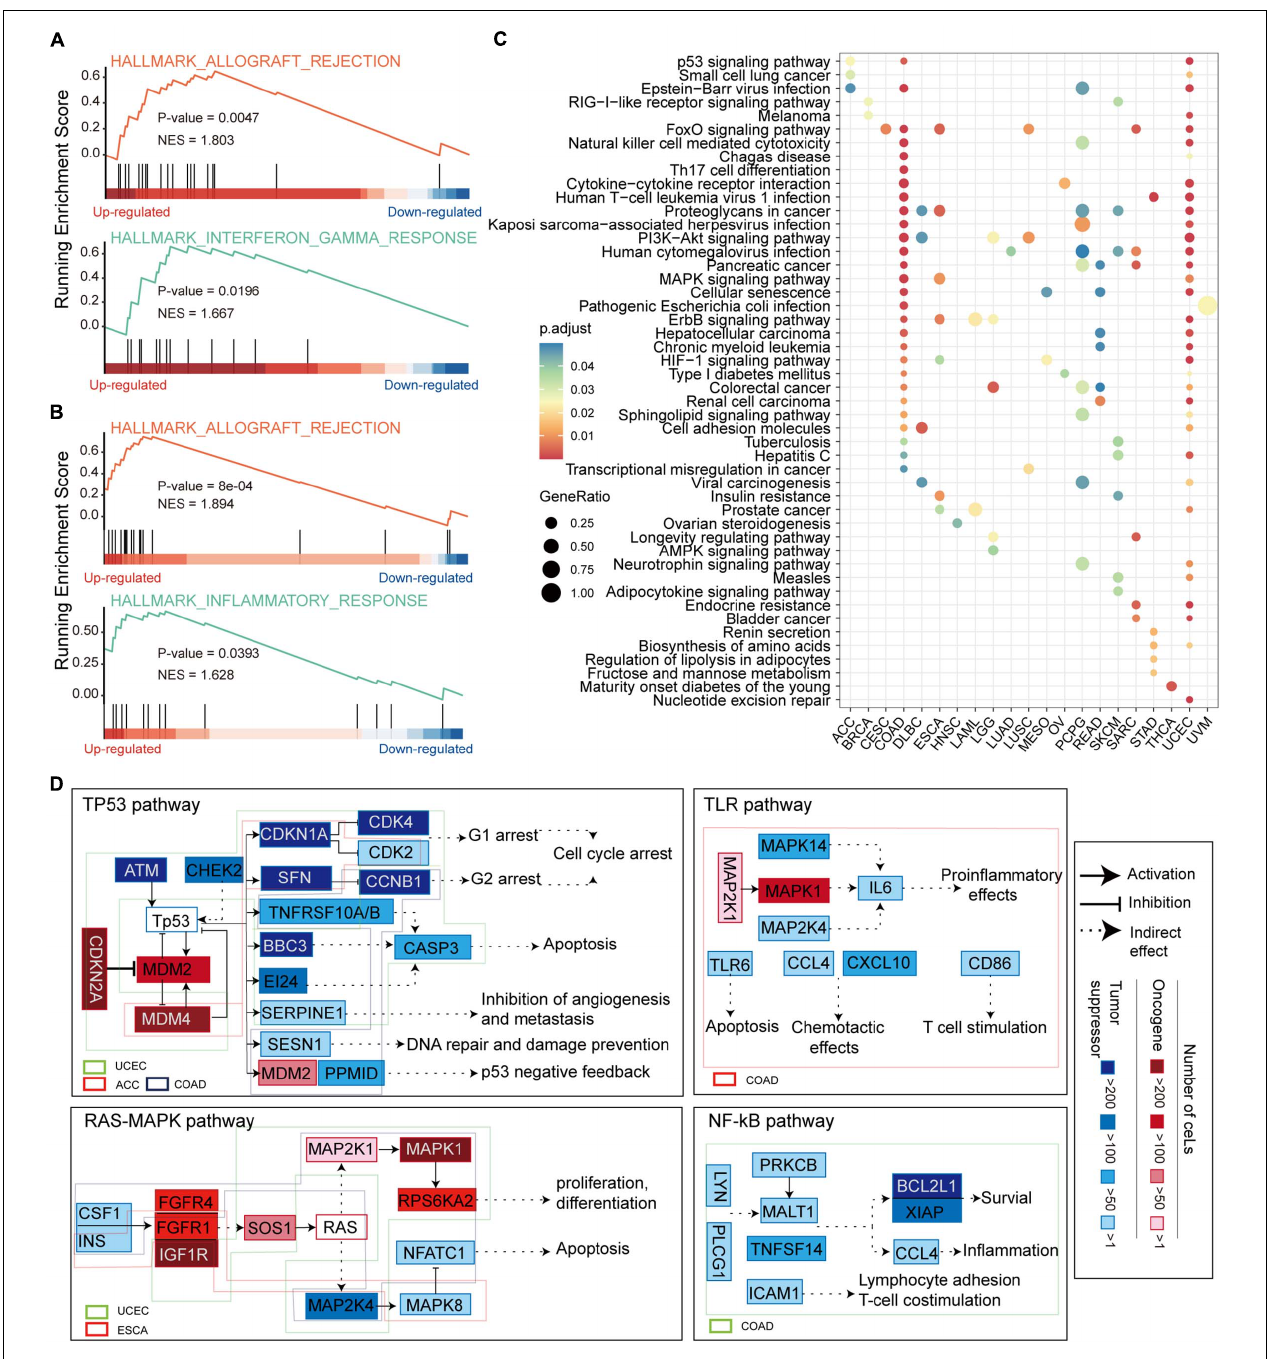
FIGURE 5 | Functional enrichment analysis of ceMs. (A) Enrichment of allograft rejection and inflammation response pathways on ceMs for COAD. (B) Same as in (A) but for UCEC. (C) Dot plot illustrating the top five pathways from functional enrichment results of ceMs for pan-cancer. (D) Signaling pathways affected by ceM mapped to illustrate the function mechanism of ceM in pan-cancer. Oncogenic and suppressor genes are shown in red and blue, respectively. Use of three categories to represent the relationships between two genes: activation, inhibition, and indirect effect.